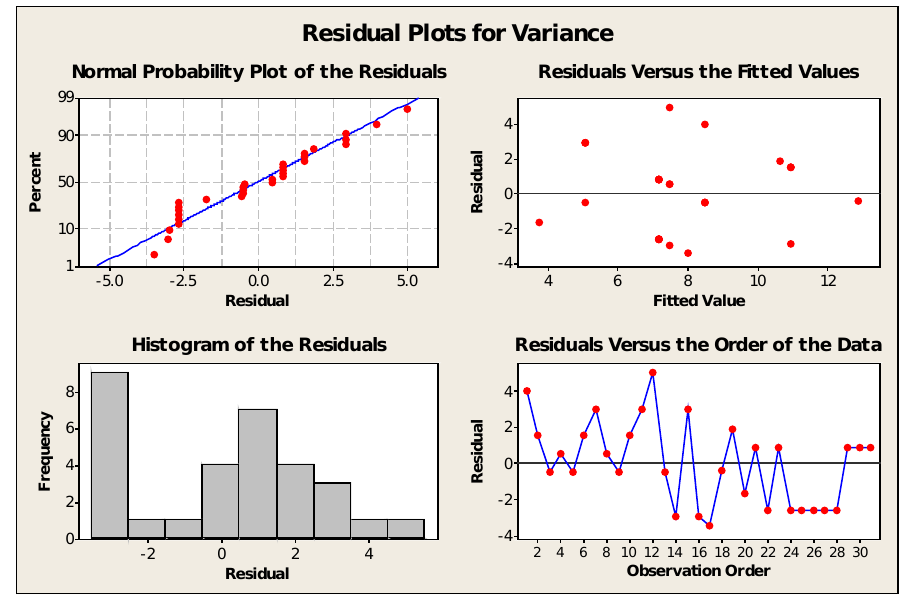
Fig. 2. Residual plots for thickness